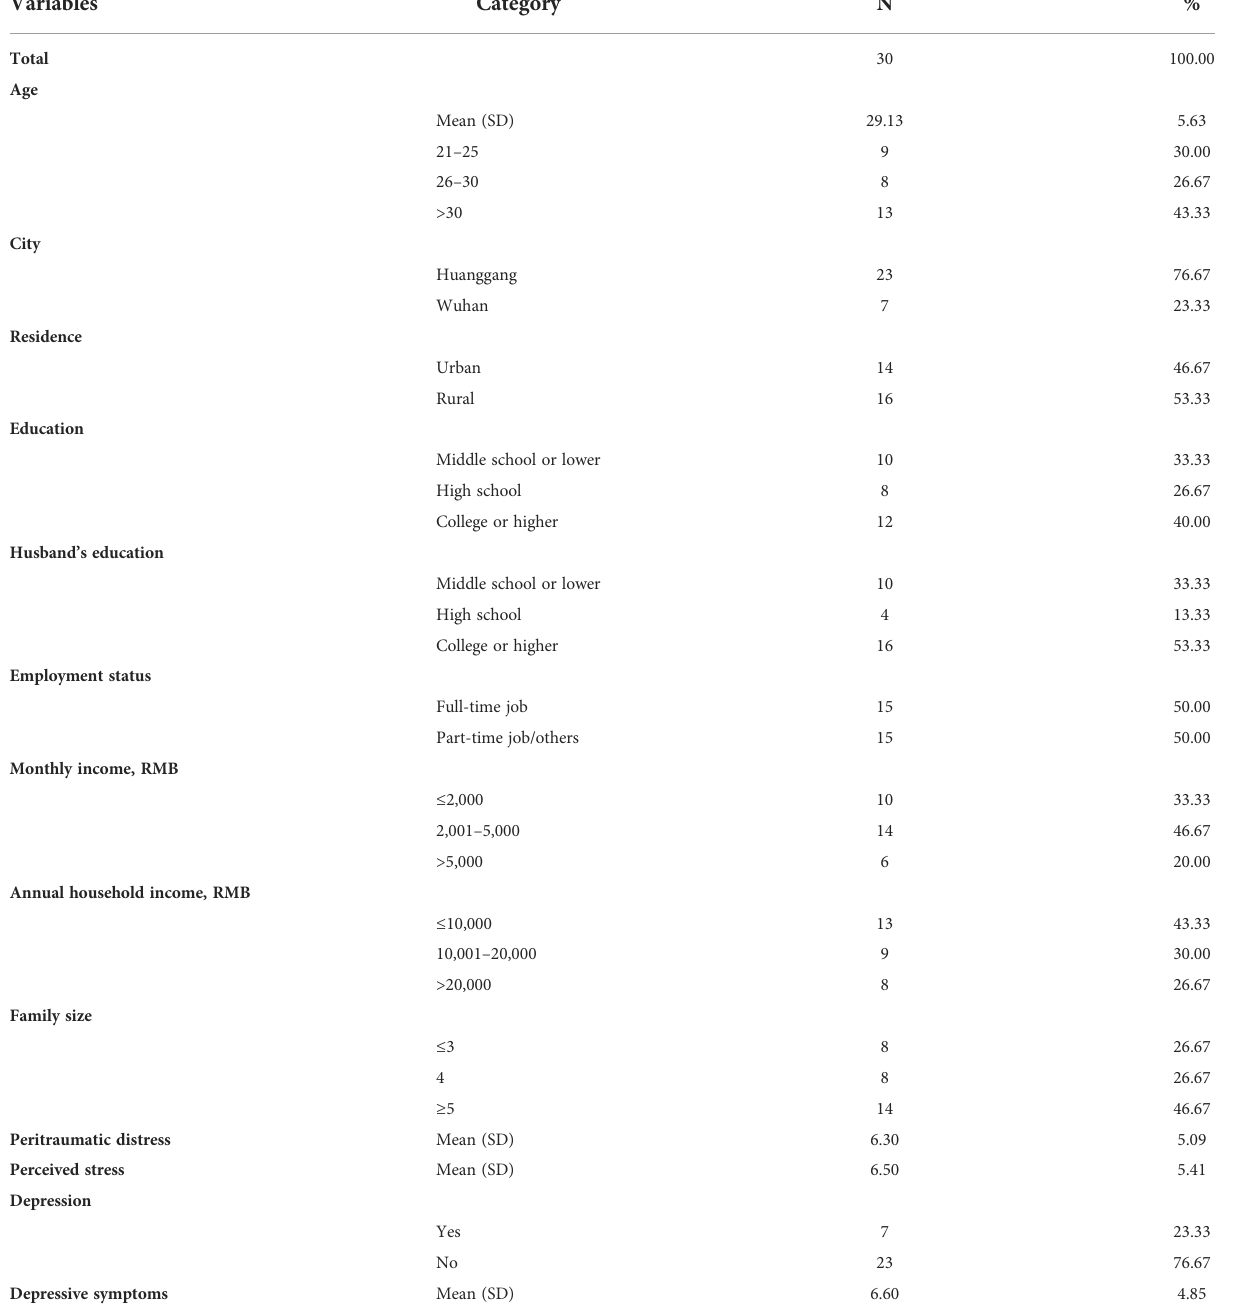
TABLE 1 Characteristics of the study